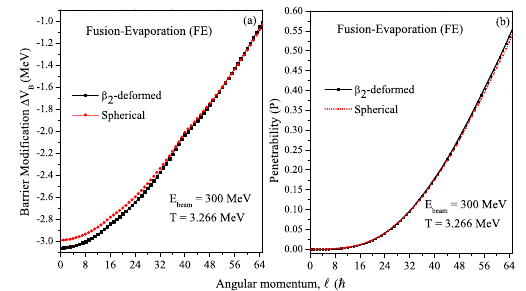
Figure 3. The variation of (a) barrier modification ( ∆ V B ) and (b) Penetrability, P as a function of angular momentum ( (cid:96) ) for Fusion-Evaporation channel at E lab = 300MeV for 88 Mo ∗ nu-